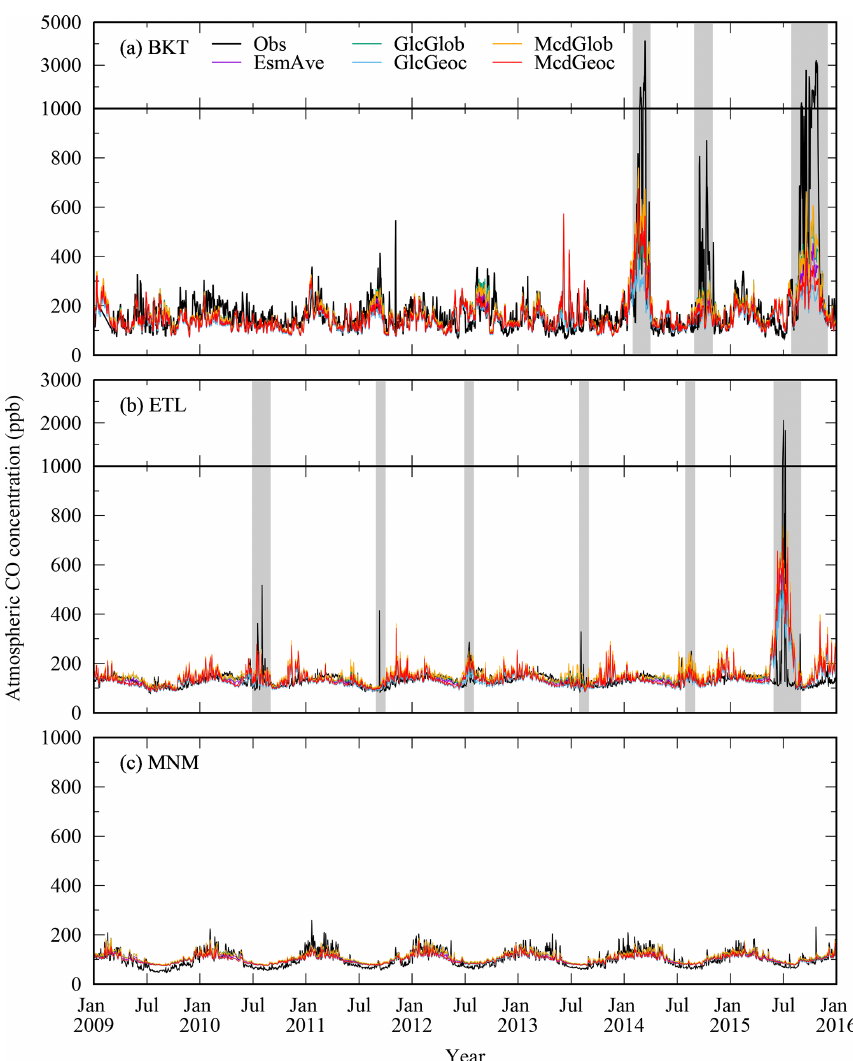
Figure 4. Daily atmospheric CO concentration variations (ppb) at the three ground-based observation stations, (a) Bukit Kototabang (BKT), (b) East Trout Lake (ETL), and (c) Minamitorishima (MNM), for 2009–2015. The gray shading for the BKT and ETL sites indicates the fire months identified using the standardized anomaly (Eq.